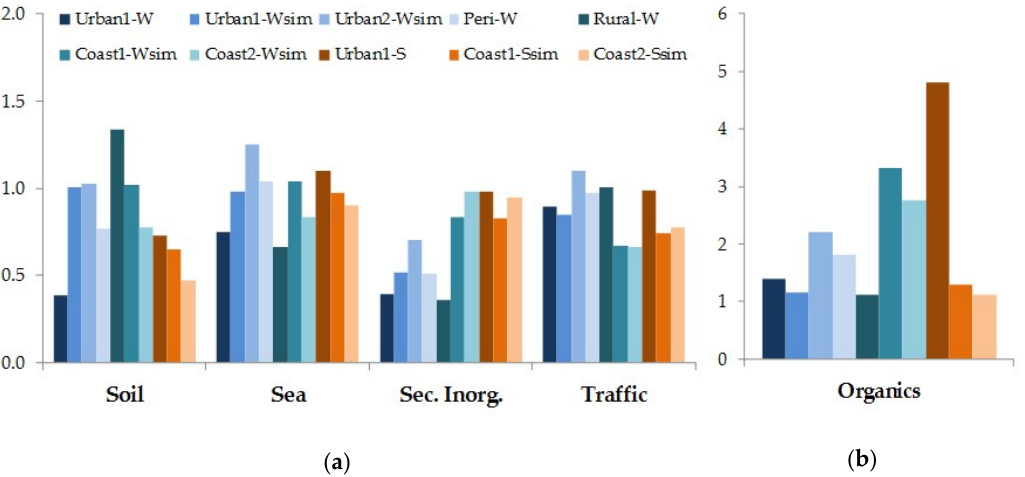
Figure 4. Average indoor-to-outdoor concentration ratios calculated for Soil, Sea, Secondary Inorganics, Traffic ( a ) and Organics ( b ).